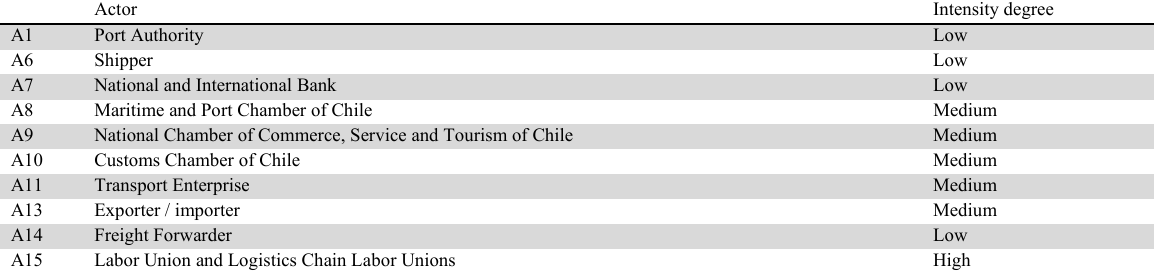
Classification of the intensity degree of the risk strategic criterion at tactical/operational level in the port